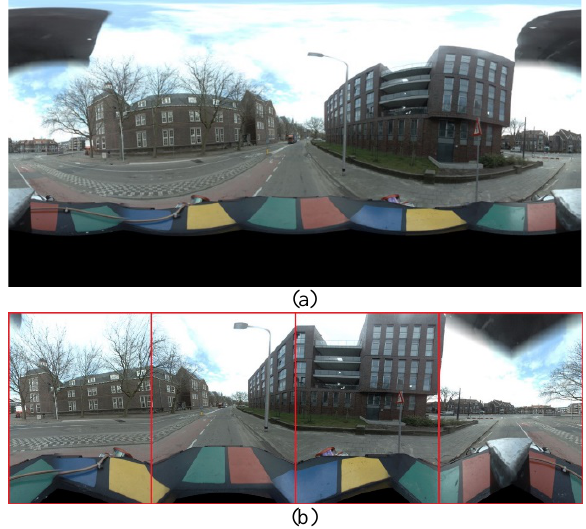
Figure 4. Transformation of the panoramic image. (a) The original panorama. (b) The transformed image. The red lines represent the margin of each direction’s